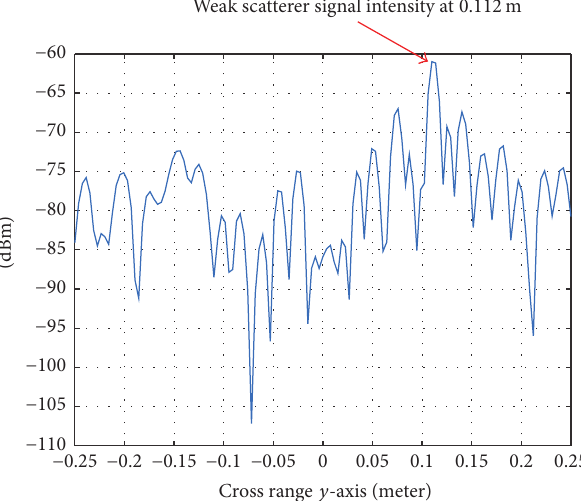
Figure 14: 𝑥 -axis cross range of weak scatterer, showing the sidelobe suppressing weak scatterer signal after applying MRL algorithm.